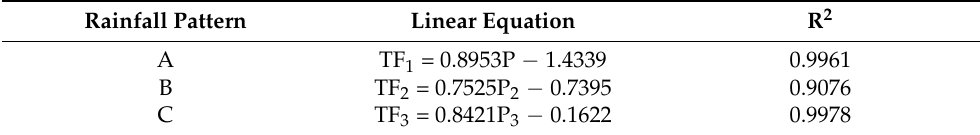
Table 3. Estimation for each rainfall pattern for TF and P. Rainfall Pattern